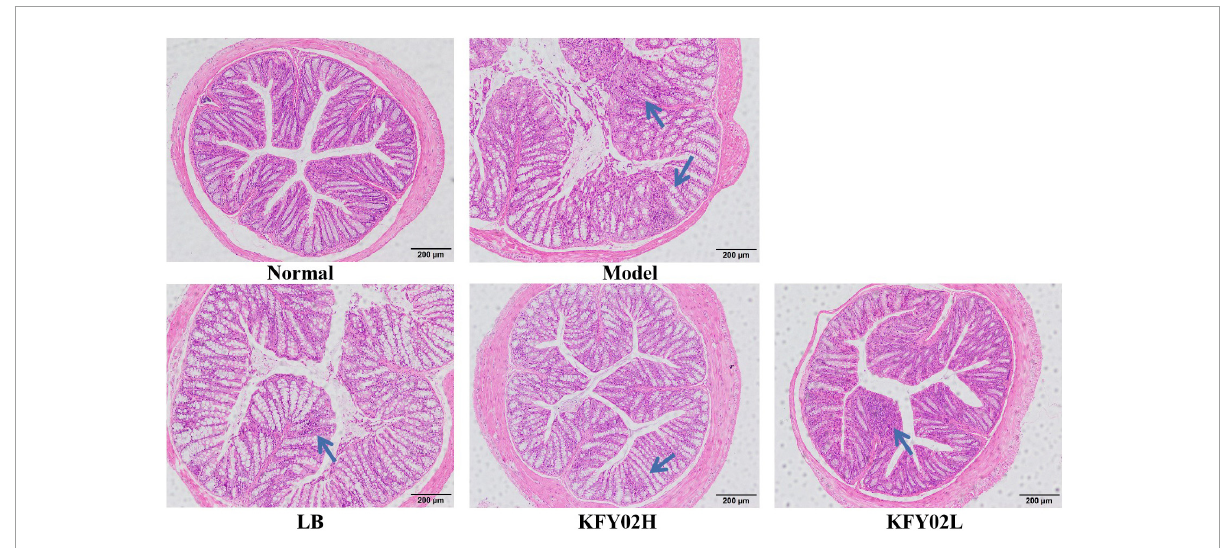
FIGURE5 Pathological assessment of H&E-stained mice colon sections; magnification 200 ×